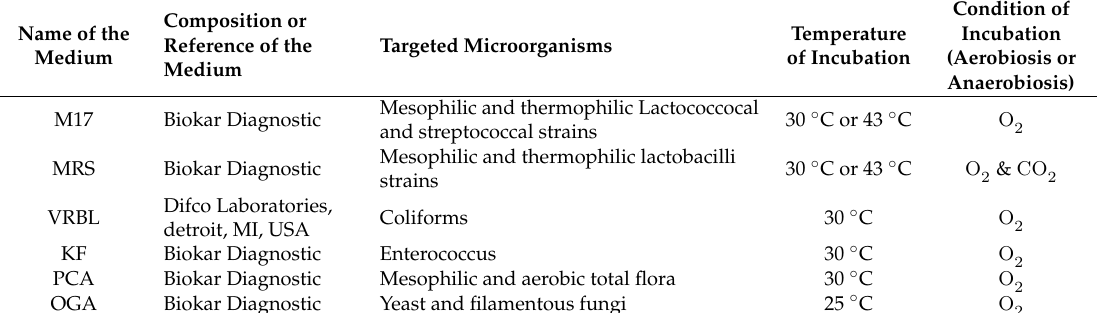
Table 2. List of the different media and incubation conditions used for the numeration step as well as the isolation of